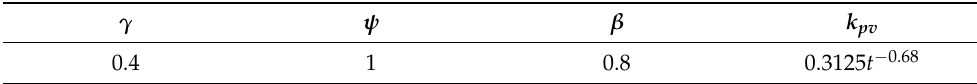
Table 2. Summary of localized corrosion model